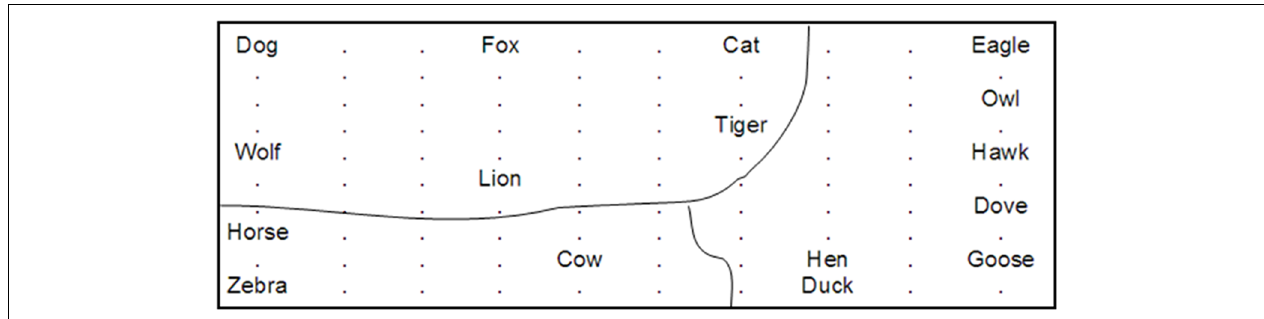
FIGURE 1 |An illustration of the learned semantic categories in a SOM model. Concepts with similar features/attributes are grouped together such as horse and zebra